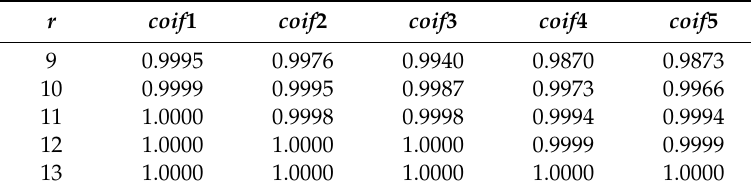
Table 26. Experimental results ( SSIM ) of 3D tomographic 8-bit image “wmri” DWT by using bit-width r of coiflets filters coe ffi cients.